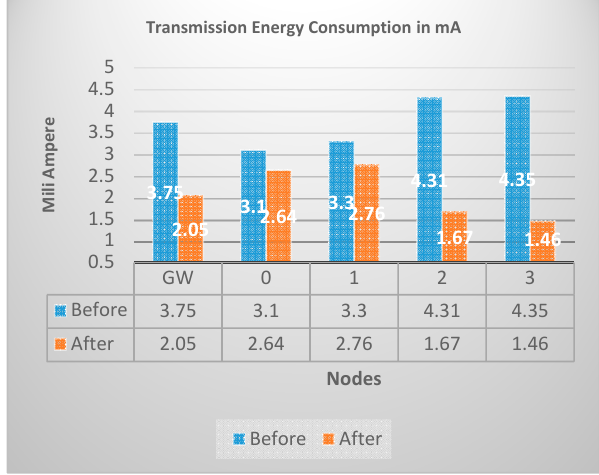
Figure 9. Transmission Energy Consumption in mA. Table 7. Energy Measurements during rainfall on node 0 (Modified AOMDV).